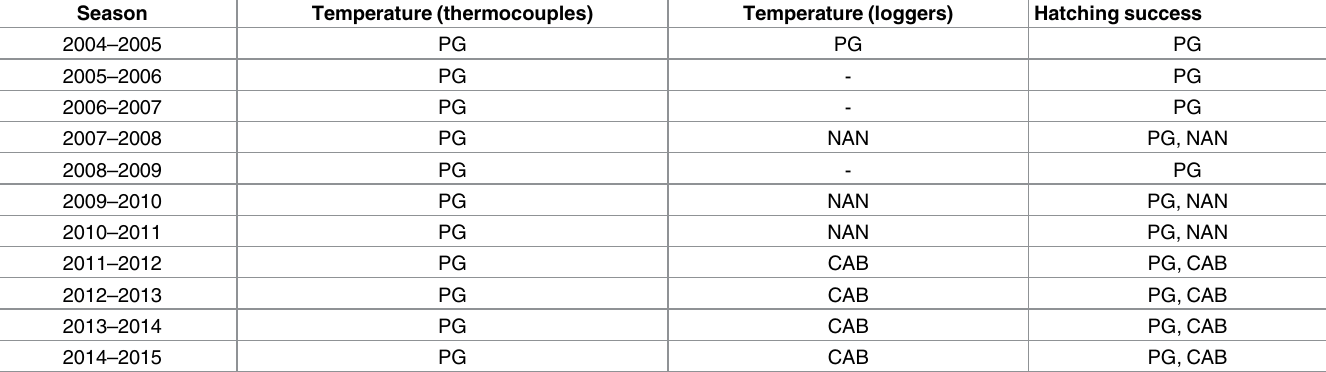
Table 2. Nesting beaches where we obtained data on nest temperatures and hatching successper season. Information from leatherback, green and olive ridley turtles was collectedat Playa Grande (PG), Cabuyal (CAB) and Nancite (NAN) respectively. Nest temperatures were monitoredwith thermocou- ples and/or